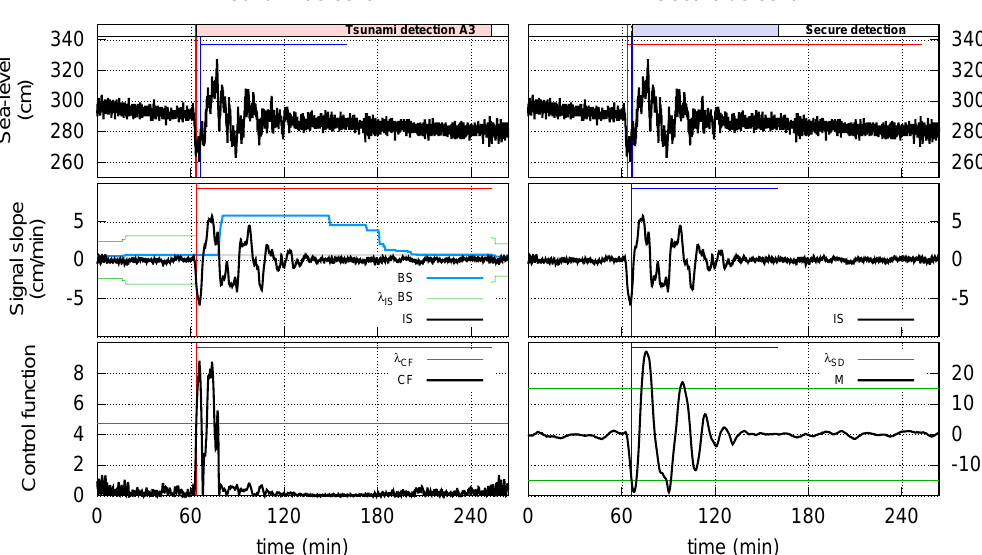
Fig. 1. TEDA functions computed in Tremestieri for the configuration C2 (see Sect. 5) during an event built by adding the 1693E tsunami signal to a calm sea record (see Sect. 7). The marigram and the tsunami and the secure-detection functions IS, BS3, CF3 and M are shown. The tsunami detections (red), secure detections (blue) and alert states are also shown, with respectively vertical and horizontal lines. In addition, for the functions IS, CF3 and M , the respective thresholds are indicated (green). In the central left panel, the value of BS( t D ), which determines the end of the tsunami state, is also indicated (grey). Table 1. Scheme of TEDA functions and detections. TEDA functions and